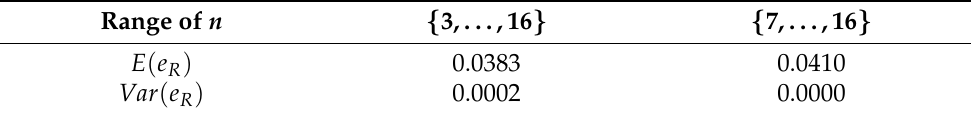
Table 5. The mean and estimated variance of the errors made when calculating P 1 n , by its recursive formula, for two different ranges of n